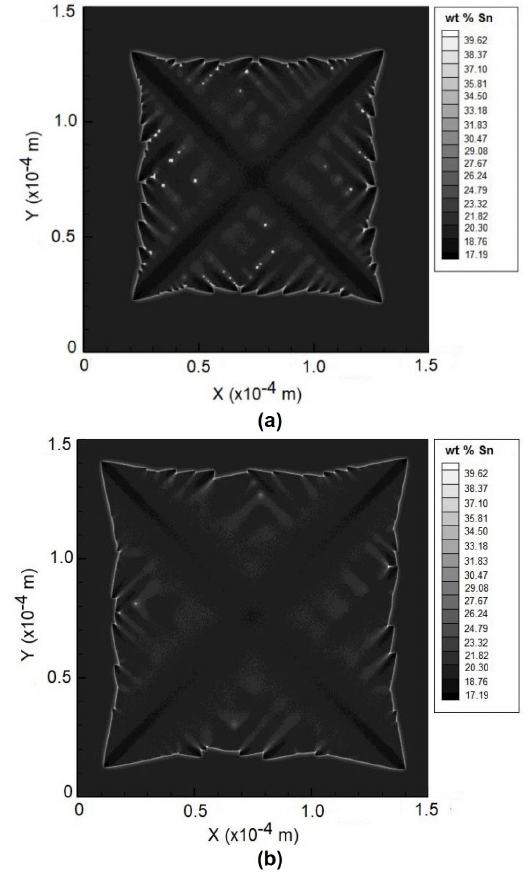
Figure 13. Dendrite shape with solidification time equal to 0.6×10 −2 s and different cooling rate: a) Ṫ = 5.1 o C/s K and, b) Ṫ = 6.2 o